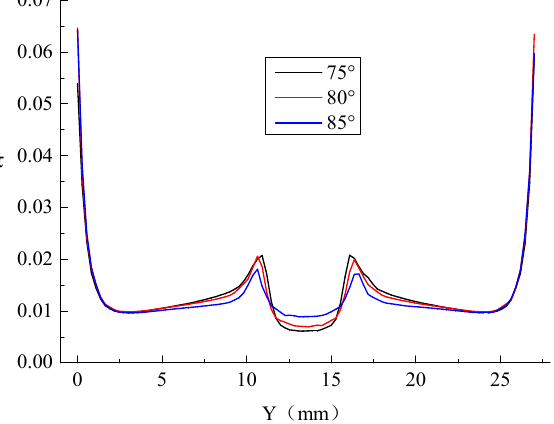
Figure 8. Coefficient distribution of pressure pulsation at the leading edge monitoring lines under different fully opening angle conditions at a flow rate of 5 L/min.